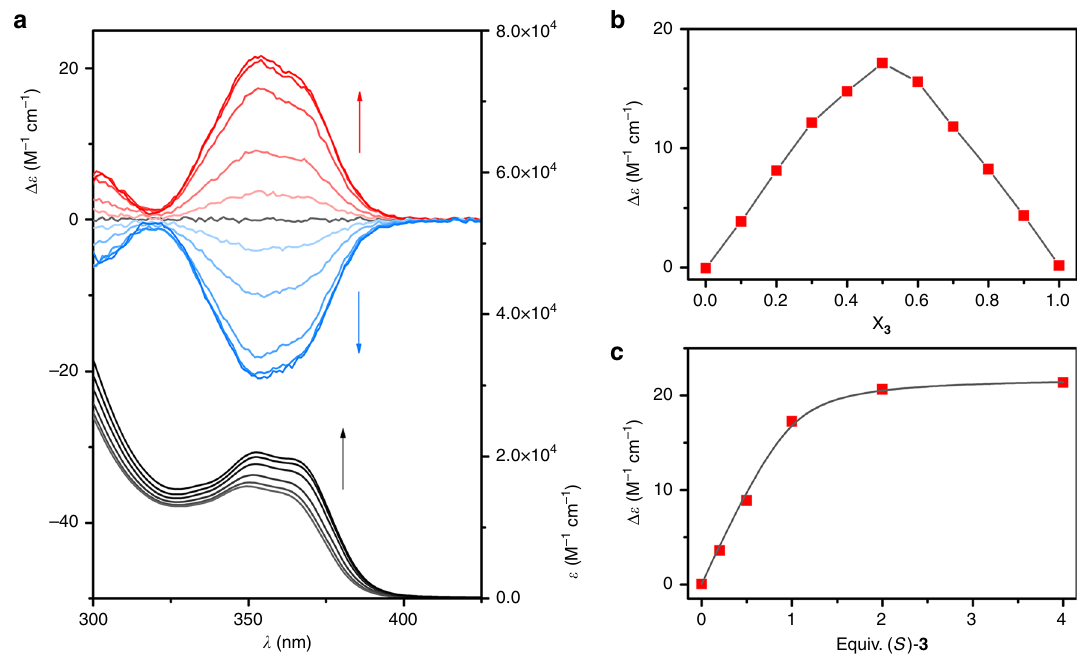
Fig. 2 Supramolecular chirality induction. a CD (top) and UV – vis (bottom) spectra of ( Z )- 2 (5.0 × 10 ‒ 4 M solution in CH 2 Cl 2 , 25 °C) in the presence of 0, 0.2, 0.5, 1.0, 2.0, and 4.0 equiv. of either [Bu 4 N] + [( S )- 3 ] ‒ (CD, red line) or [Bu 4 N] + [( R )- 3 ] ‒ (CD, blue line). The appearance of a CD signal upon chiral phosphate addition reveals preferential formation of one of the helical forms of ( Z )- 2 . b Job plot analysis obtained by mixing ( Z )- 2 with [Bu 4 N] + [( S )- 3 ] ‒ (1.0 × 10 ‒ 3 M solutions in CH 2 Cl 2 , 25 °C) showing the CD absorption as function of the mole fraction of the latter (X 3 ). The maximum at 0.5 indicates a 1:1 binding stoichiometry. c Plot of the CD absorption versus the amount of equiv. of [Bu 4 N] + [( S )- 3 ] ‒ added and the calculated 1:1 binding isotherm ( K a = 2.8 ± 0.3 × 10 4 M − 1